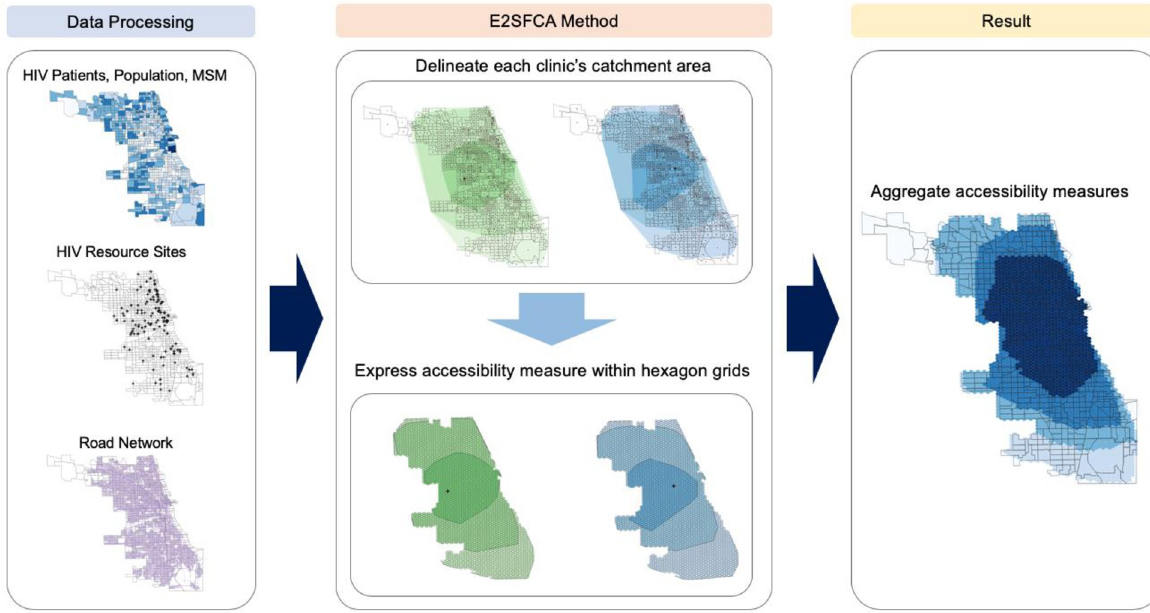
Fig 5. Workflow. Note: The value of each hexagon is determined by A i from Eq (2).